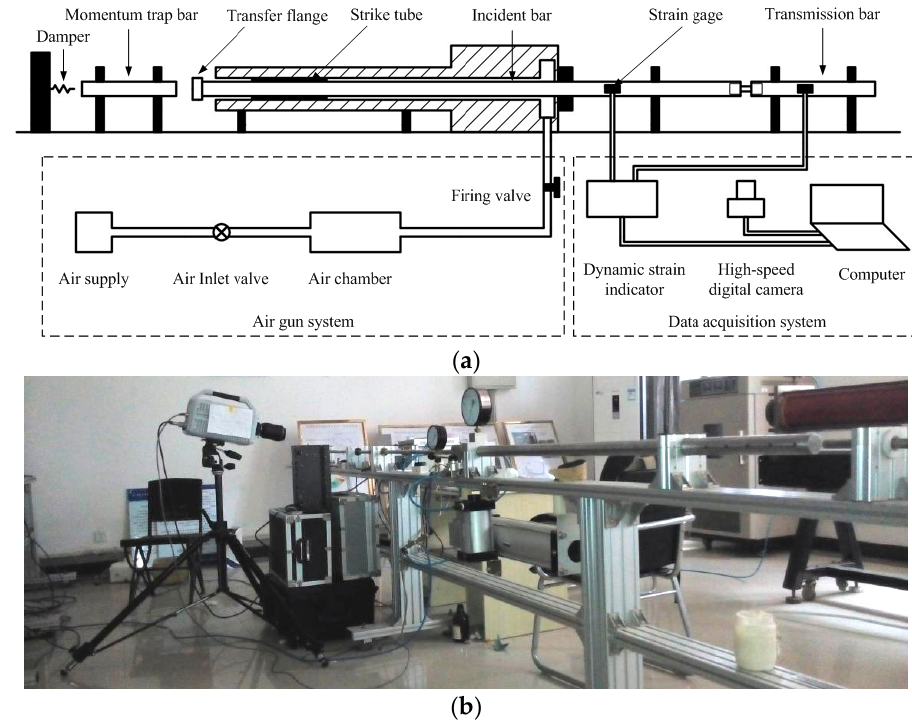
Figure 2. The SHTB test system: ( a ) schematic diagram; and ( b ) photograph.